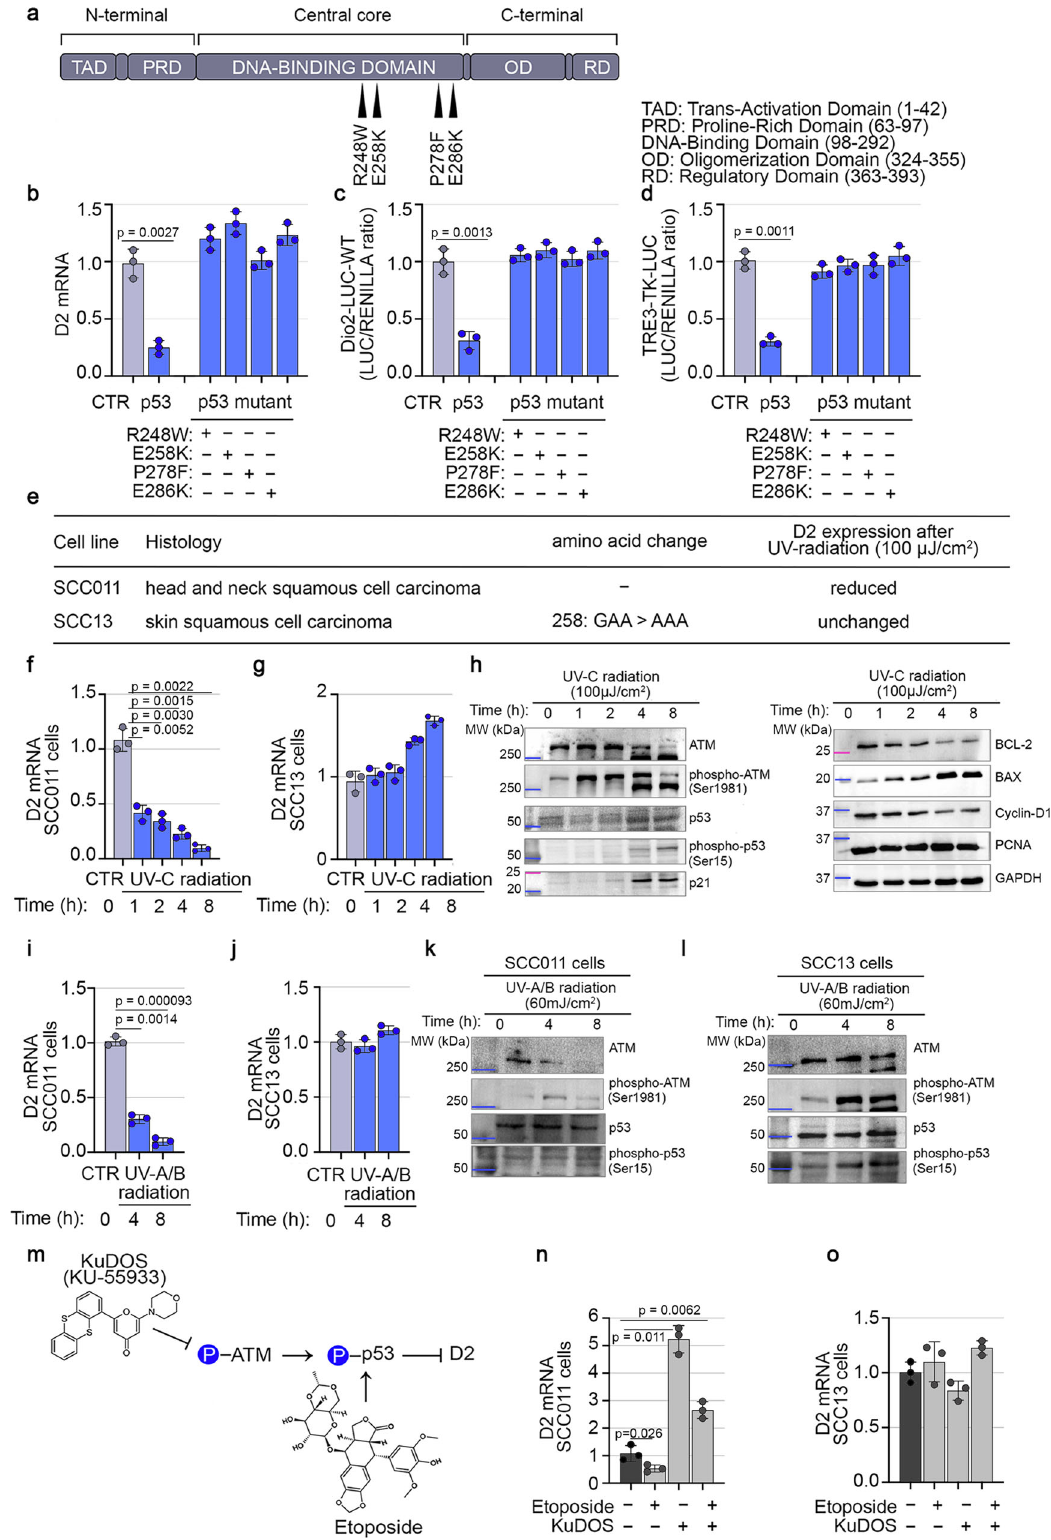
(Fig. 5a). We found 111 Differentially Expressed Genes (DEGs, 65 of them negatively regulated for value of Log 2 Fold-Change (FC) ≤− 1.5 and 46 positively regulated for value of Log 2 Fold-Change (FC) ≥− 1.5, both with p <0.05) between p53KO +/ − ;D2KO and p53KO +/ − ;D2WT mice (Fig. 5b, c, SupplementaryFig. 10 and SupplementaryData 1). Based